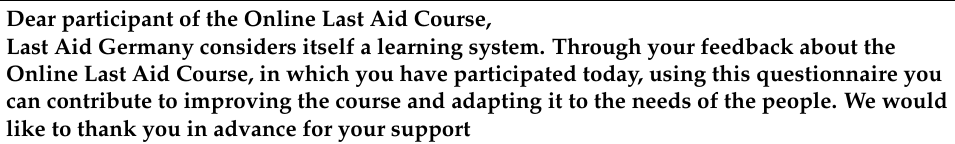
Table A1. The Online Last Aid Course